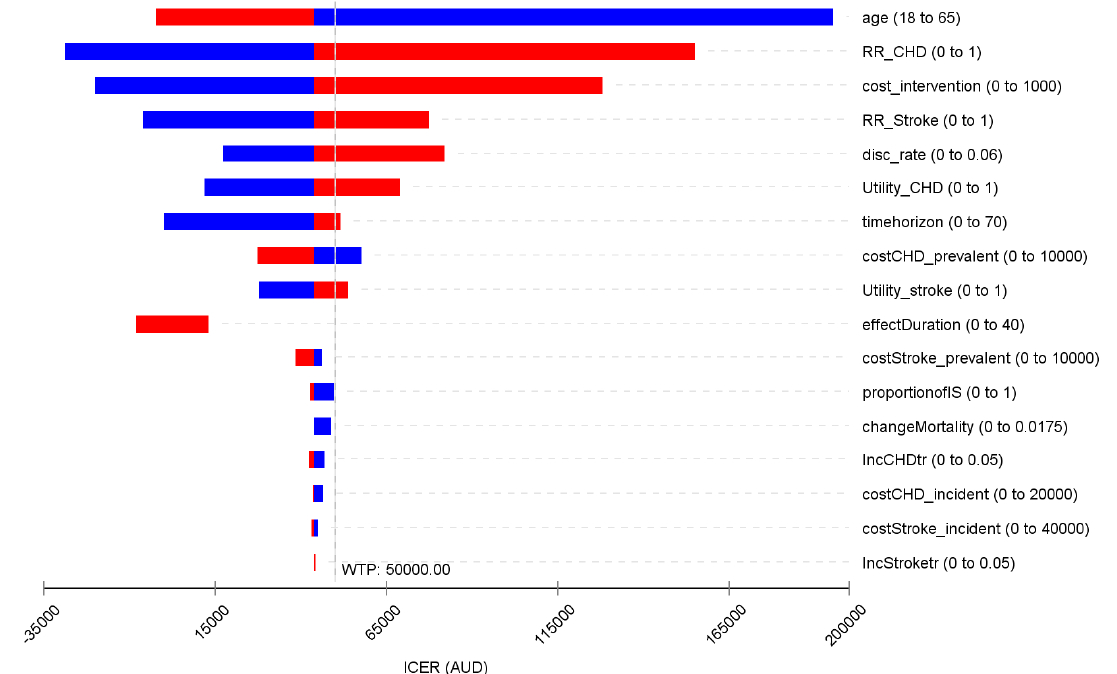
Figure 1. Tornado diagram for the deterministic sensitivity analyses. WTP: willingness to pay; ICER: incremental cost-effectiveness ratio; AUD: Australia dollar; CHD: coronary heart disease; RR: relative risk. Note: blue bar means the ICER decreases as parameter value increases; red bar represents ICER increases as parameter value increases. Table 2. Results of cost-effectiveness analysis.